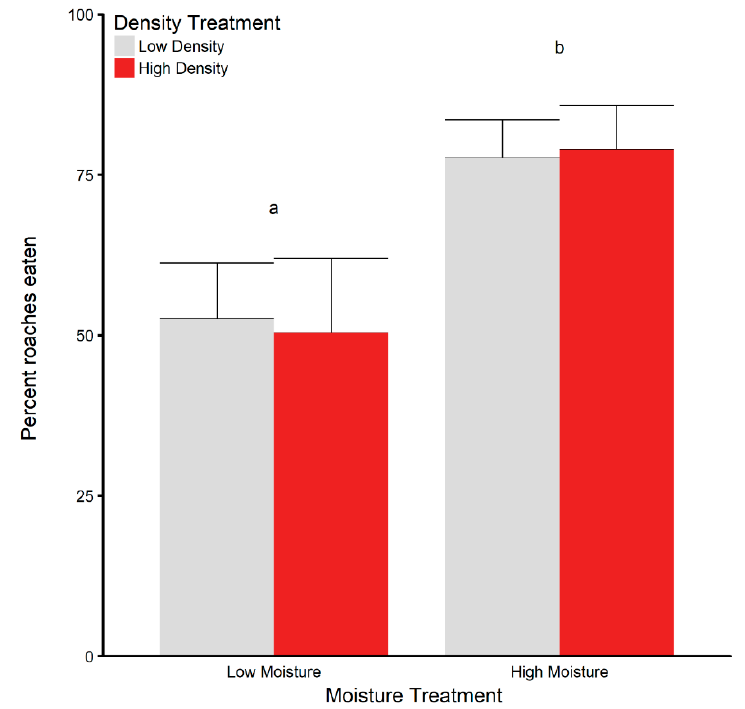
Figure 5. Mean percent roaches eaten across low and high terrestrial moisture treatments and high larval density (grey bars) and high larval density (red bars) + SE. Letters over bars represent significant differences between moisture treatments at p = 0.05.